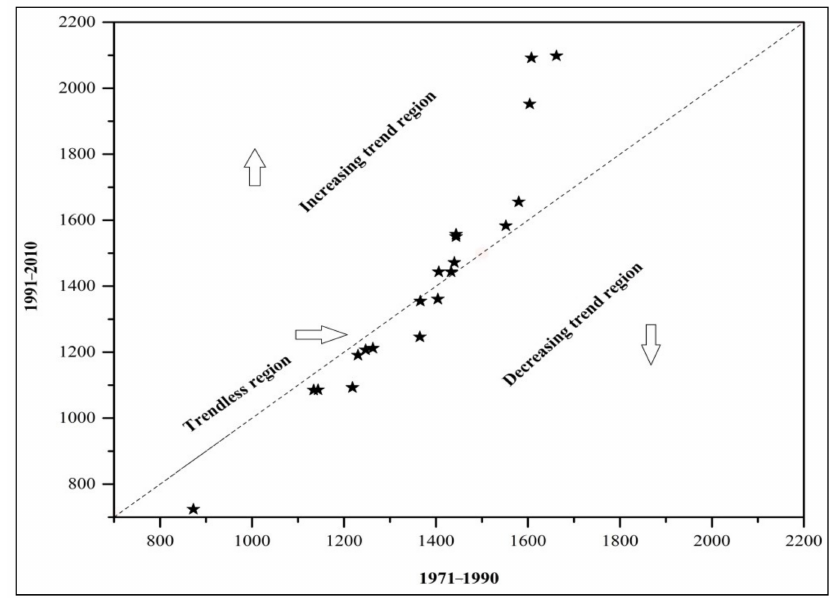
Figure 3. Interpretation of the ITA